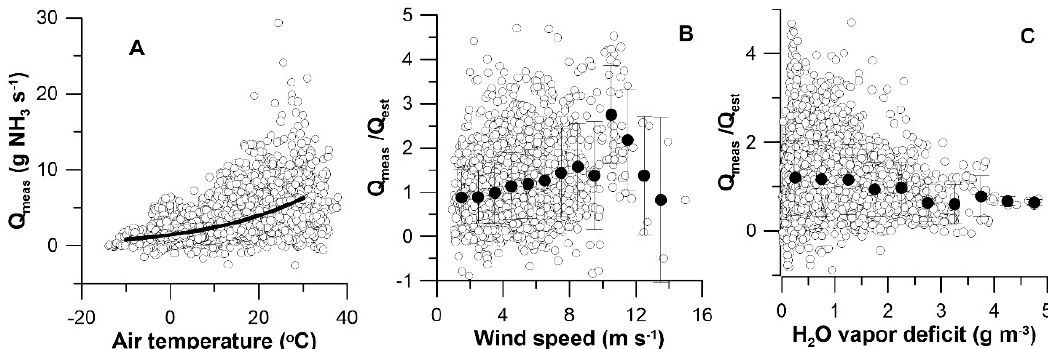
Figure 4. Influence of air temperature, wind speed and saturation water vapor deficit on half-hourly NH 3 emissions. Panel ( A ) illustrates the correlation between air temperature at 1 m height and 30-min mean emissions (open circle) and the best-fit emissions estimation model including only air temperature as variate (Equation (3); solid line). Panels ( B , C ) illustrate the relationship between the measured and modeled emissions and wind speed and saturation water vapor deficit (open circles). The ratio of measured and modeled emission (Q meas / Q est ) was classified (wind speed at 0.5 ms − 1 intervals and water vapor deficit at 0.5 gm − 3 intervals) with mean and standard deviation of the mean of each classified bin indicated. Linear regressions of the classified wind speed (between 0 and 8 ms − 1 ) on Q meas / Q est had an R 2 of 0.05. Linear regressions of the classified vapor deficit (between 0 and 3.5 gm − 3 ) on Q meas / Q est had an R 2 of 0.02.